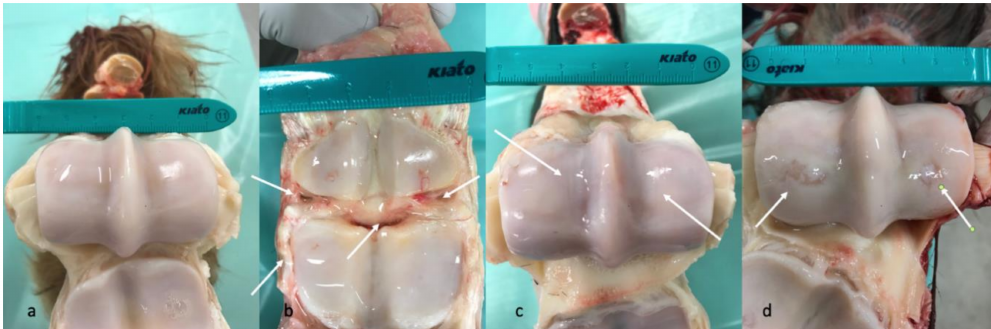
Figure3. Imagepanelrepresentativeofsomeofthefindingsfromthemacroscopicpathologyevaluations described in the study. ( a ) The opened fetlock of horse #6 showing smooth glistening cartilage surfaces with no synovial hyperplasia and no signs of wear lines or erosions. ( b ) The opened fetlock of horse #3 showing a moderate to marked degree of synovial hyperplasia ( white arrows ). ( c ) The opened fetlock of horse #14 showing a mild to moderate degree of superficial wear lines on both condyles of the third metacarpal bone ( white arrows ). ( d ) The opened fetlock of horse #4 showing severe full thickness erosions of the cartilage of the central distal parts of the medial and lateral condyles of the third metacarpal bone ( white arrows